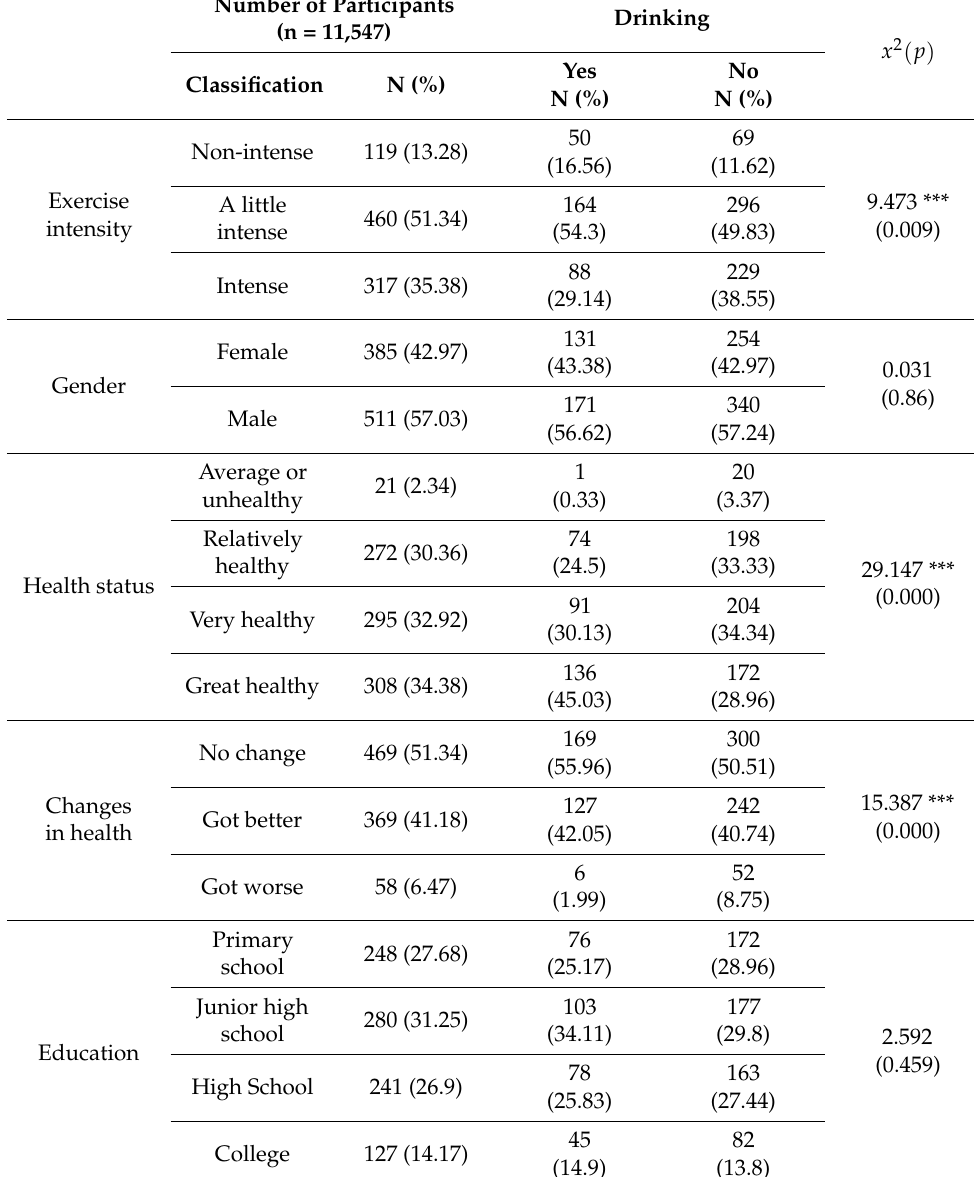
Table 1. Distribution of general